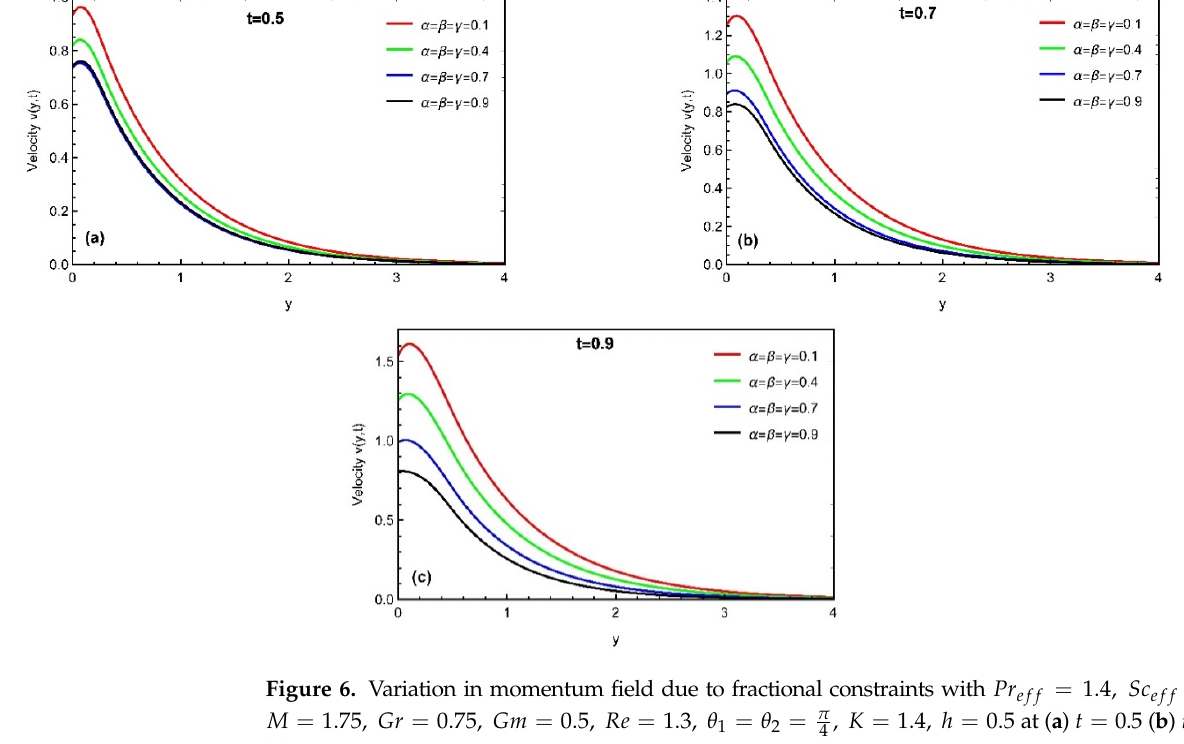
, 𝐾 = 1.4, ℎ = 0.5 at ( a ) 𝑡 = 0.5 ( b ) 𝑡 = , K = 1.4, h = 0.5 at ( a ) t = 0.5 ( b ) t = 0.7 4 (cid:2872)